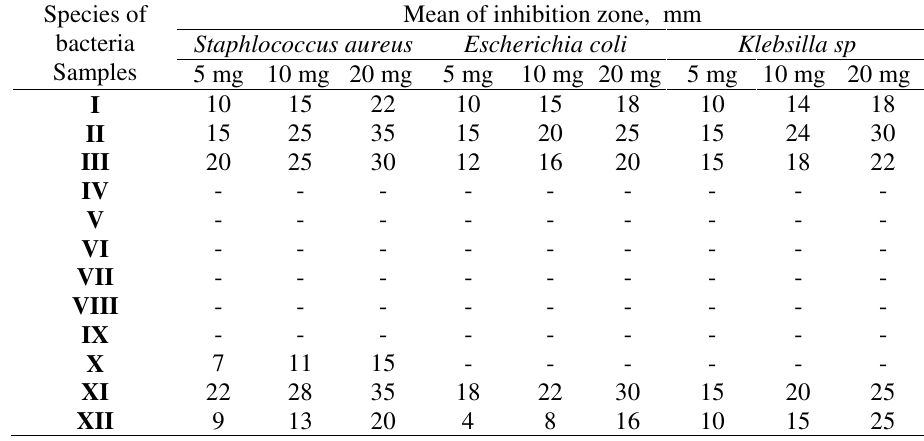
Table 1. The effect of Schiff bases on bacteria growth Mean of inhibition zone, mm Species of Staphlococcus aureus Escherichia coli